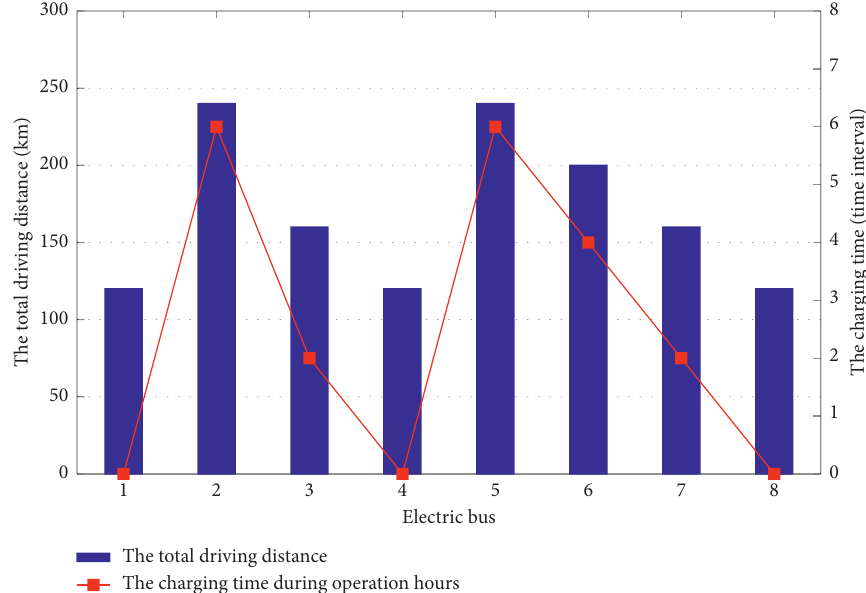
Figure 7: Relationship between the total driving distance and charging time for each electric bus.